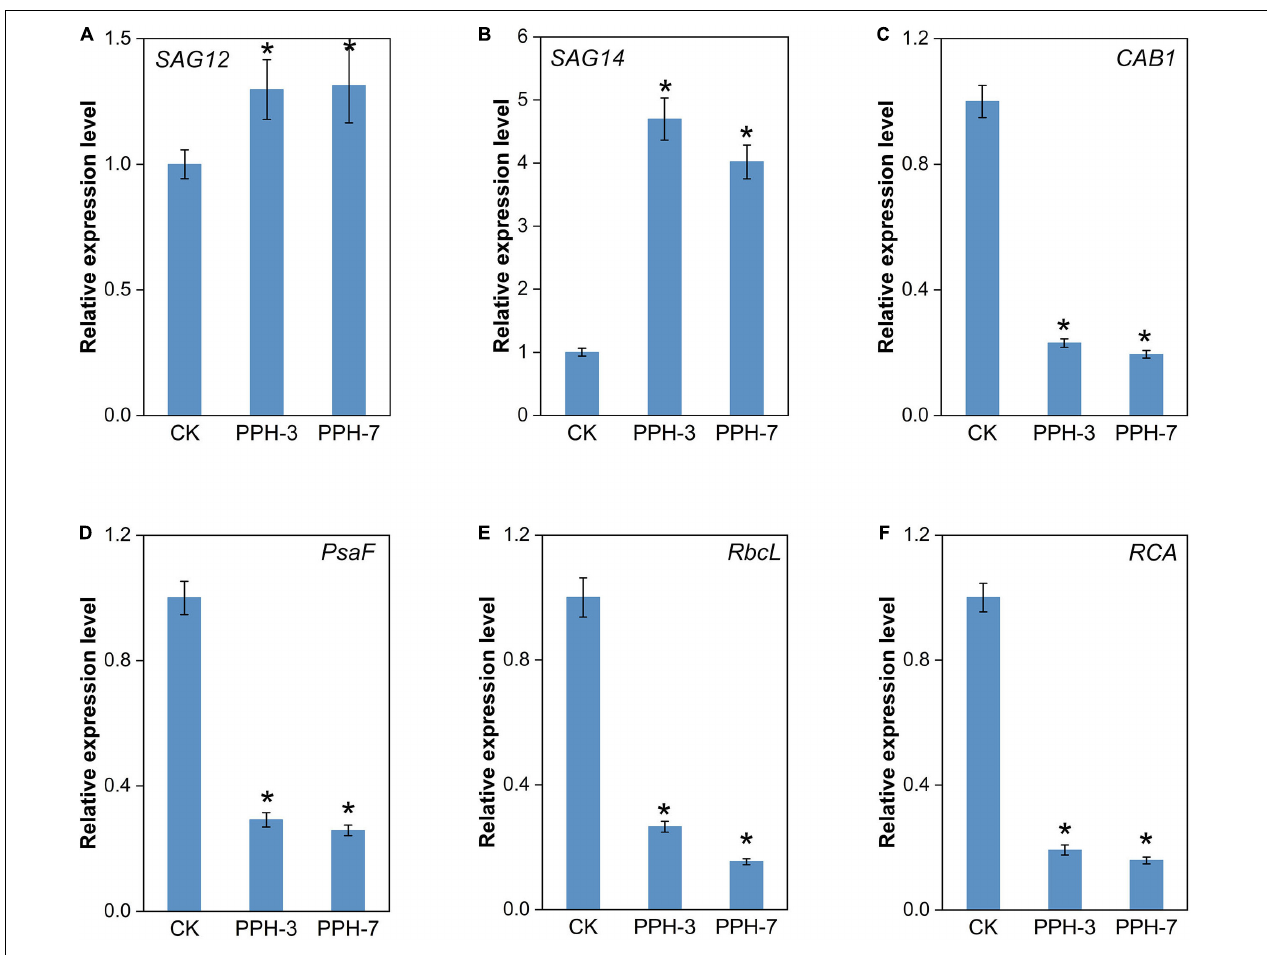
FIGURE 6 | Expression analysis of senescence markers and photosynthesis-related genes. (A) SAG12 . (B) SAG14 . (C) CAB1 . (D) PsaF . (E) RbcL . (F) RCA . Data were expressed as mean ± SD ( n = 4). *Indicate significant differences at p ≤ 0.05 based on Student’s t -test.